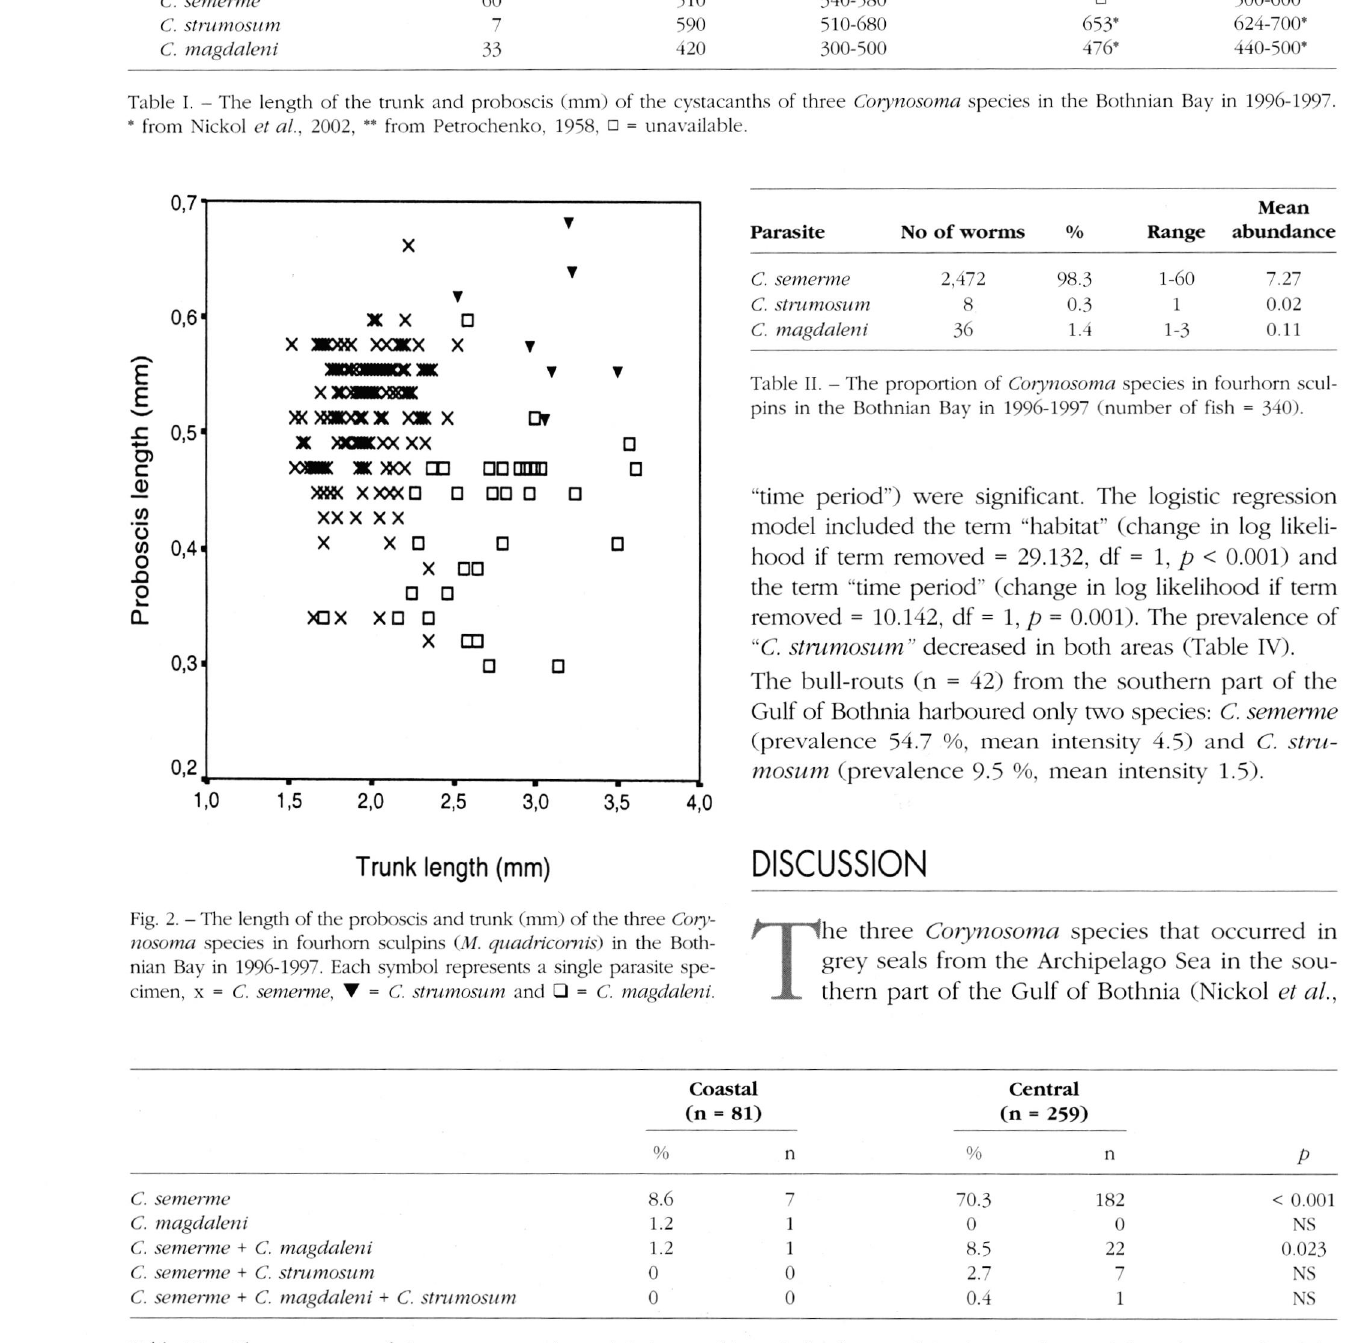
Table I. - The length of the trunk and proboscis (mm) of the cystacanths of three Corynosoma species in the Bothnian Bay in 1996-1997. * from Nickol et al., 2002, " from Petrochenko, 1958, • = unavailable.